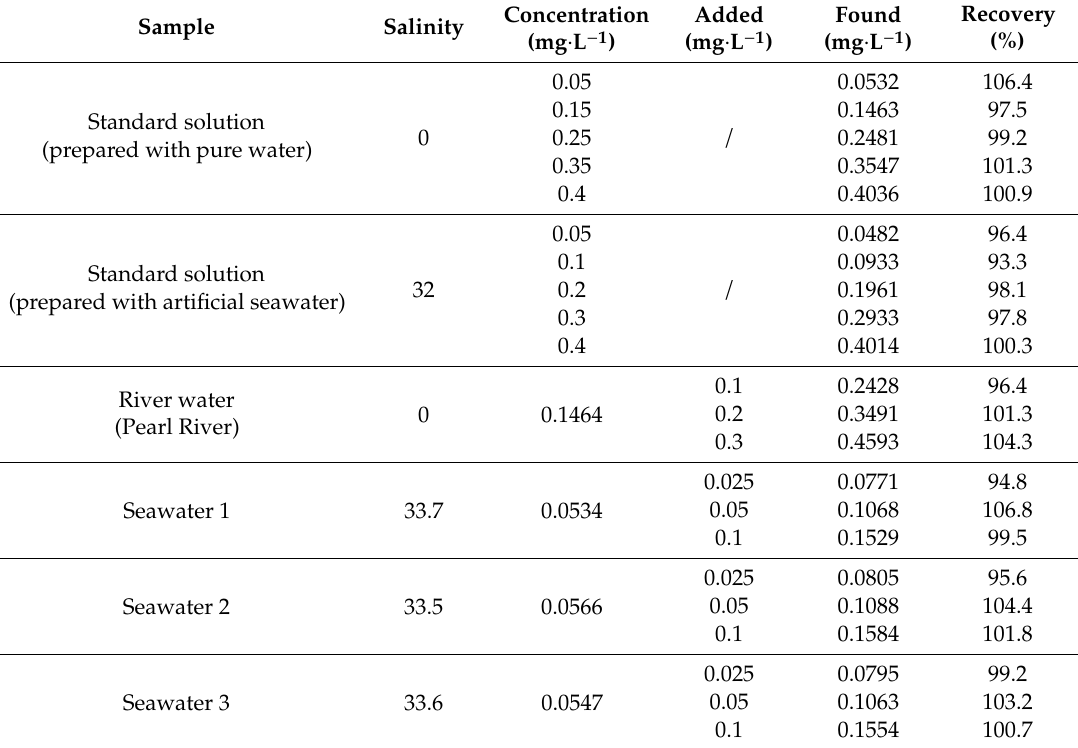
Table 1. Blank recovery and sample recovery of various water samples.